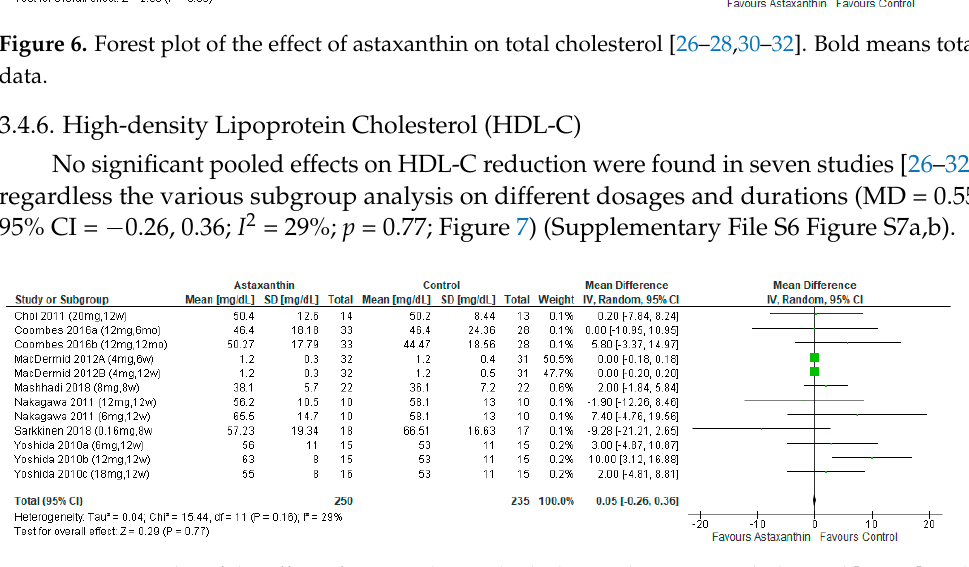
Figure 7. Forest plot of the effect of astaxanthin on high-density lipoprotein cholesterol [26–32]. Bold means total data.